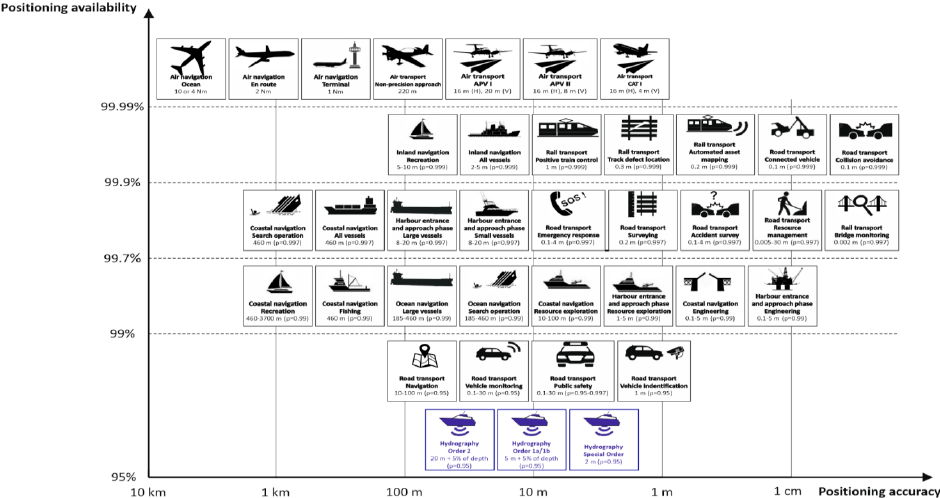
Figure 1. Requirements for positioning system accuracy and availability in hydrography compared to other navigation types. Own study based on: